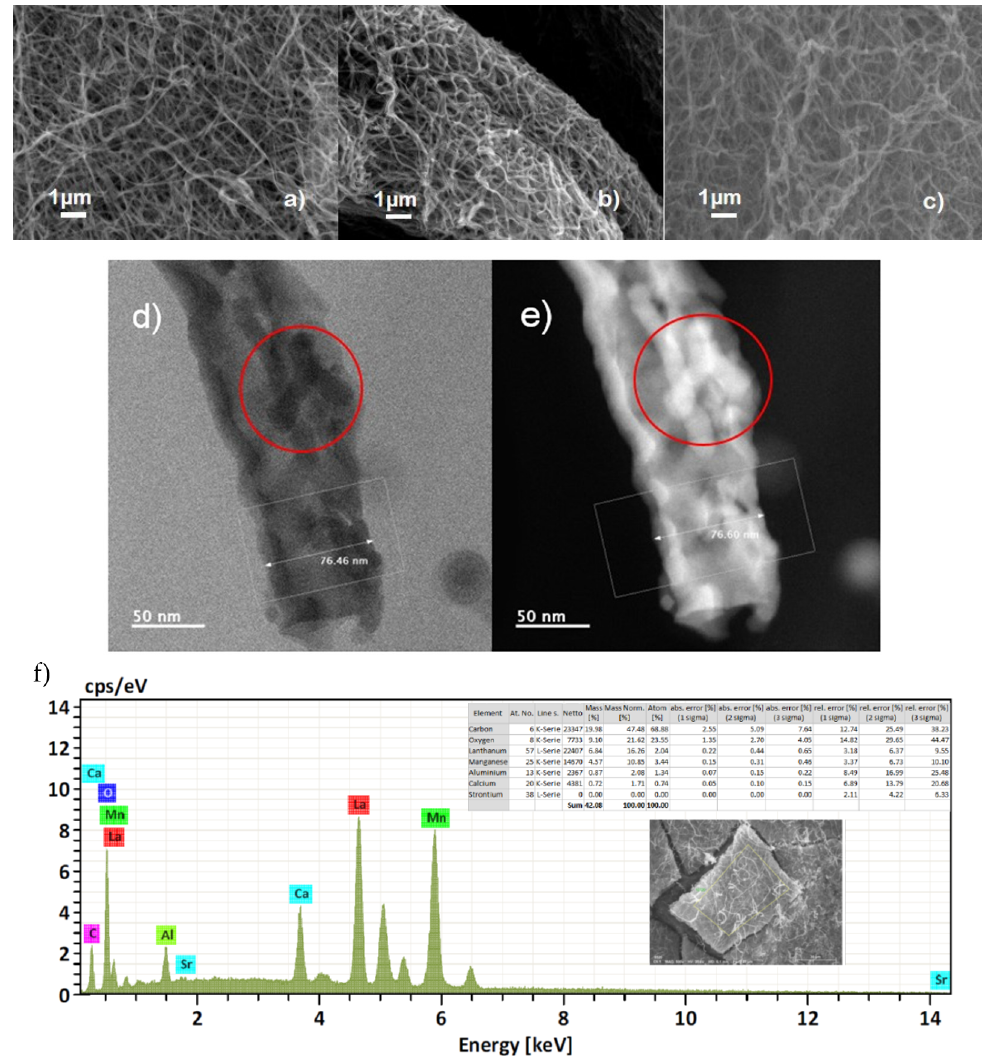
Figure 2. Top: scanning electron micrographs for La 0.7 Ca 0.23 Sr 0.07 MnO 3 nanofibers at ( a ) 973 K, (b) 1073 K and ( c ) 1173 K. Bottom: ( d ) and ( e ) Scanning transmission electron micrographs for La 0.7 Ca 0.23 Sr 0.07 MnO 3 nanofiber in dark and bright field modes (Z-contrast); red circle denotes coalescence effect among granular colonies of La 0.7 Ca 0.23 Sr 0.07 MnO 3 . ( f ) Energy-dispersed X-ray spectra and chemical count analysis.